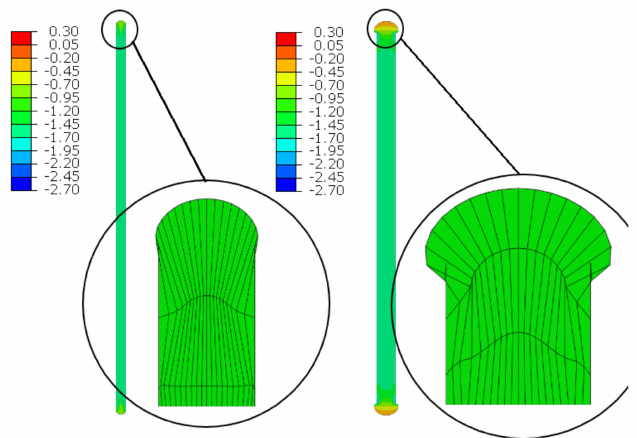
Figure 20. Deformations for scaling factor 1.0 and Cauchy stresses σ z in MPa for total load level. The width of the gap is equal to 1.0 cm, left graphic, and 2.0 cm, right graphic. Details of deformation are enlarged.